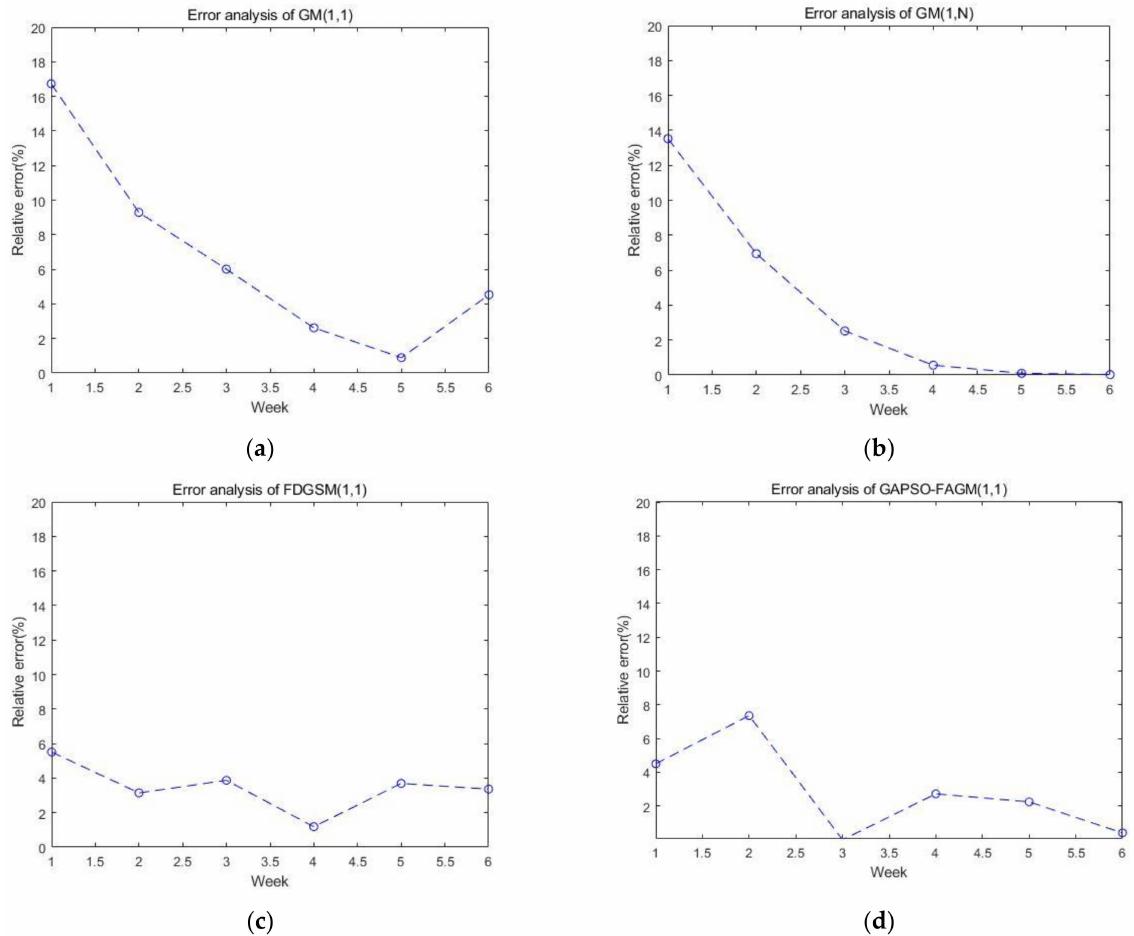
Figure 6. The error analysis of the test set using the four models: ( a ) error analysis of GM(1,1); ( b ) error analysis of GM(1,N); ( c ) error analysis of FDGSM(1,1); and ( d ) error analysis of GAPSO-FAGM(1,1).